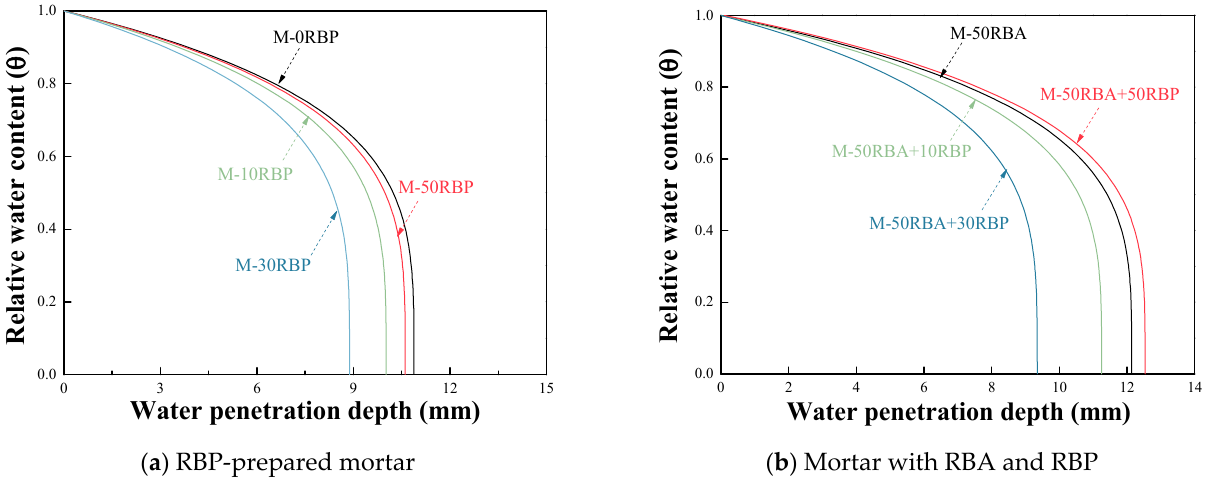
Figure 13. Water distribution in cement mortar with RBA and RBP.